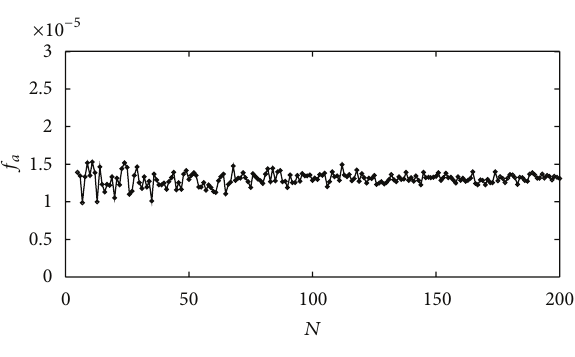
Figure 6: Relationship between 𝑓 𝑎 and 𝑁 with intermittent release measures.